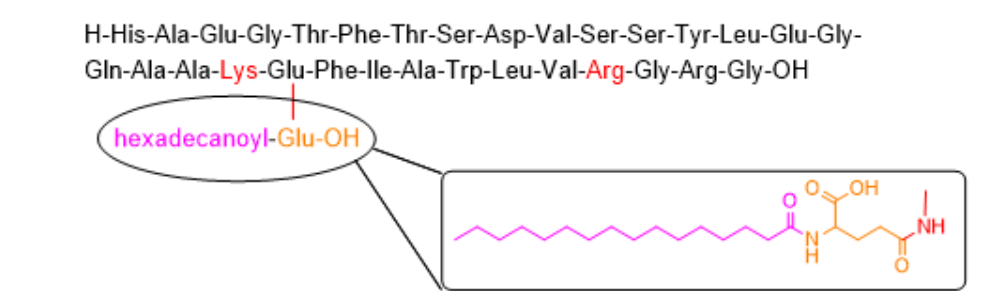
Figure 5. Structure of ( a ) semaglutide and ( b ) its related liraglutide. Changes in structure with respect to GLP ‐ 1 (7 ‐ 37) are shown in color.